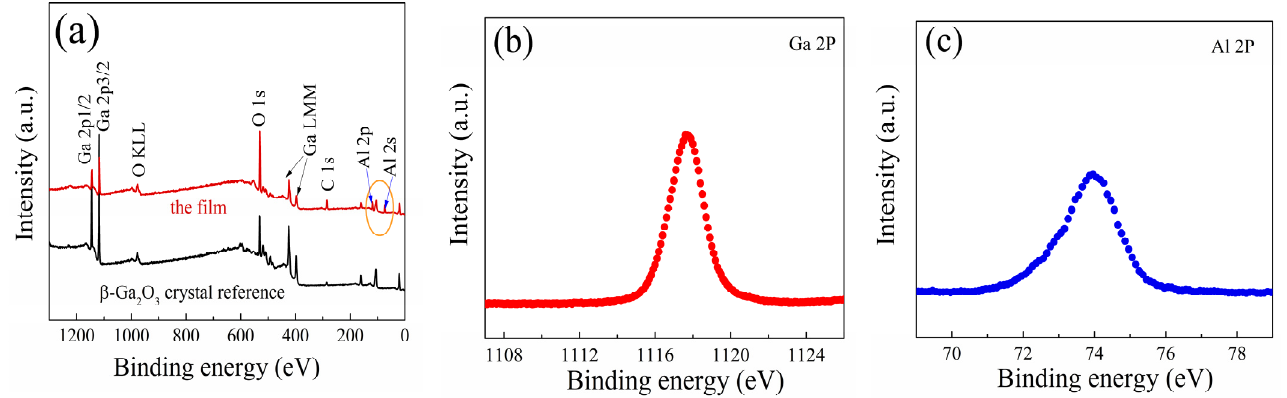
Figure 5. The XPS wide survey spectra of β -(Al x Ga 1 − x ) 2 O 3 film on sapphire substrate ( a ). The Al 2p core-level spectra ( b ) and Ga 2p core-level spectra ( c ).